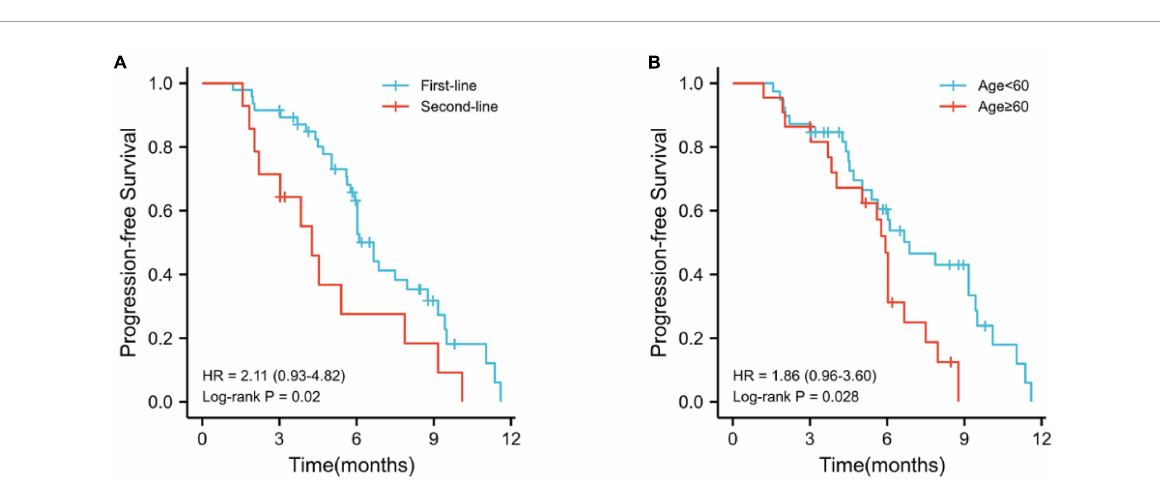
treatment lines (first-line treatment vs. second-line treatment, HR = 3.215; 95% CI 1.520–6.951; p < 0.05) and age ( < 60